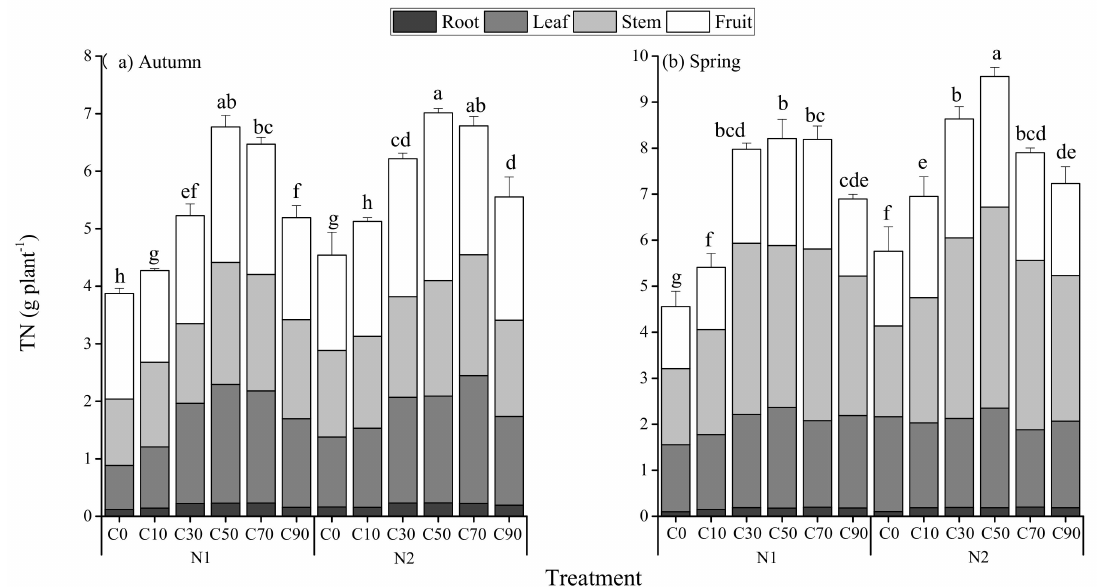
Figure 5. Tomato plant total N uptake (TN) in each organ for the N fertiliser (N1 and N2) and biochar (C0, C10, C30, C50, C70, and C90) treatments. Error bars represent standard errors. Different lowercase letters (a–h) denote significant differences among the treatment means at the 0.05 level by Duncan’s MRT